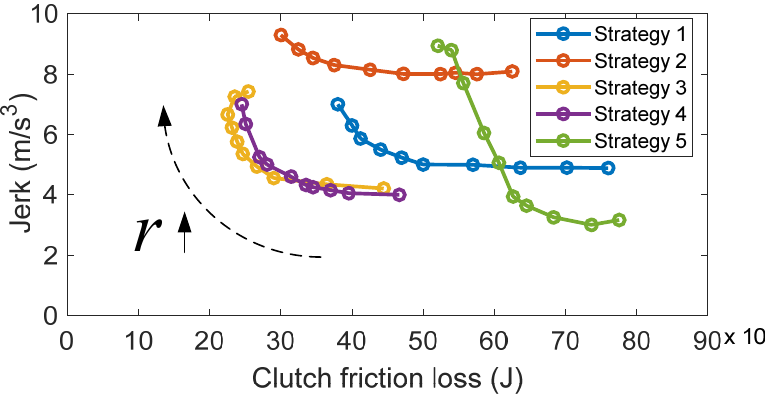
Figure 4. Pareto frontiers for five control strategies with a different weighting factor r .